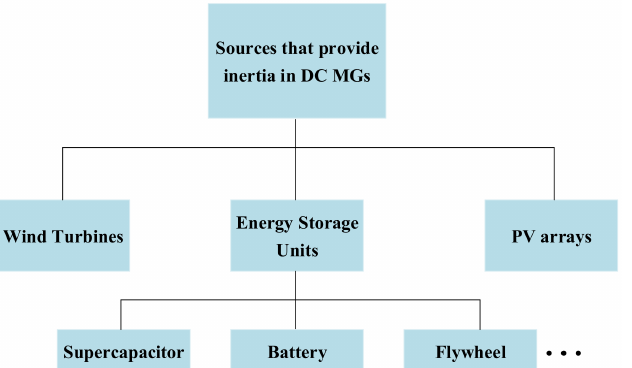
Figure 4. The classification of inertia-providing sources in dc